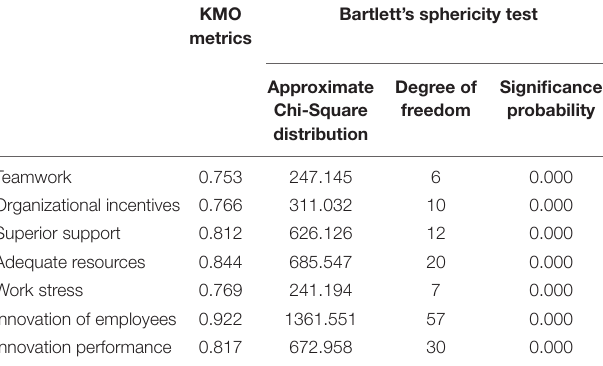
TABLE 4 | KMO and sphericity